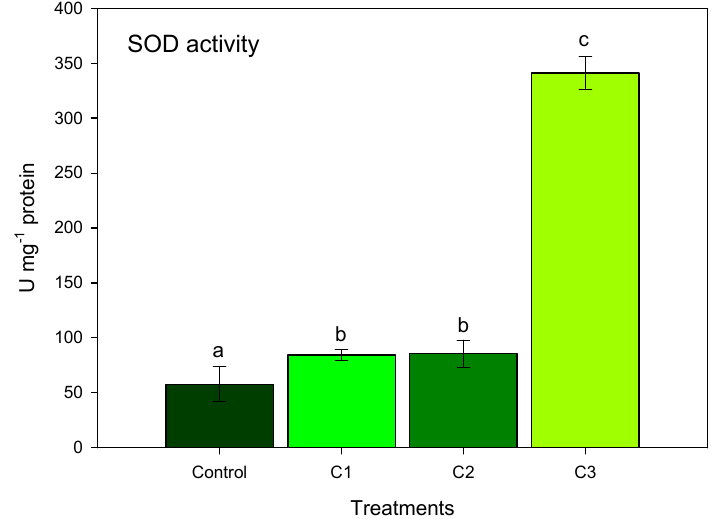
Figure 2. Total superoxide dismutase (SOD) activity in the different treatments of Exp. No. 2. Data were obtained from pepper leaves at the first harvest (98 days). Data represent the mean of eight independent replicates and the same lower-case letter among treatments indicates that they are not statistically different according to one-way ANOVA with Tukey–Kramer post-hoc test at p < 0.05. Control, plants grown with full nutrient solution; C1, C2, and C3, plants grown with 8%, 17%, and 33% ( v / v ) compost, respectively, and supplemented with NO 3 − 14.92 mM.